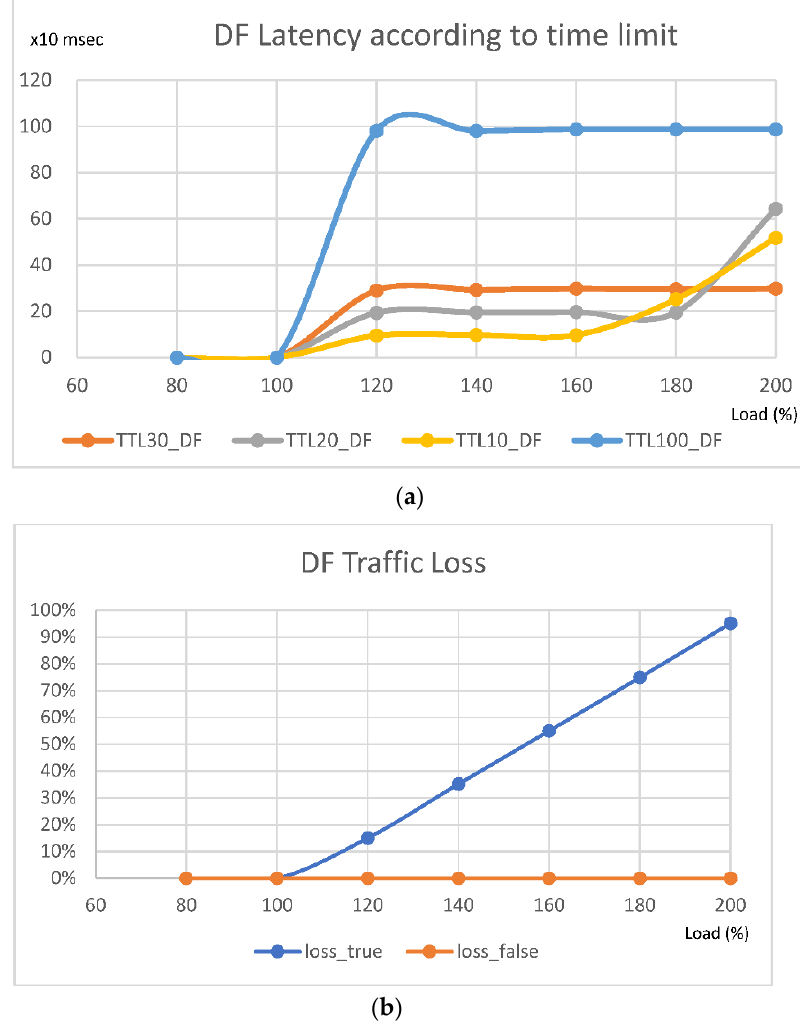
Figure 4. Performance results of the DF traffic: ( a ) Latency performance of the DF traffic; ( b ) Loss performance of the DF traffic.